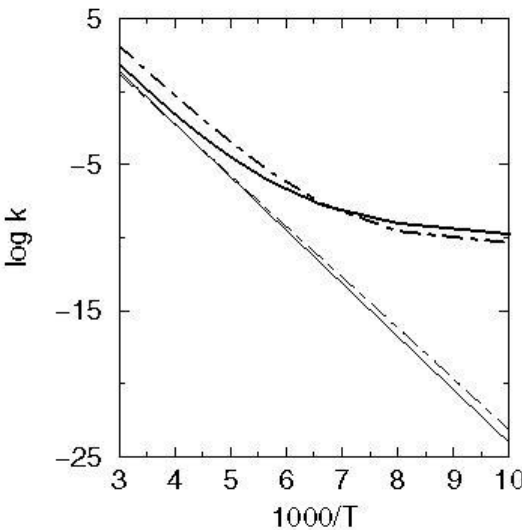
Figure 5. Calculated overall rate constants (thick lines) for the dissociation of a single ammonia molecule on the model Si cluster, for the intra-dimer (solid lines) and inter-dimer (broken lines) pathways. The thin lines represent the contribution of the classical over-the-barrier